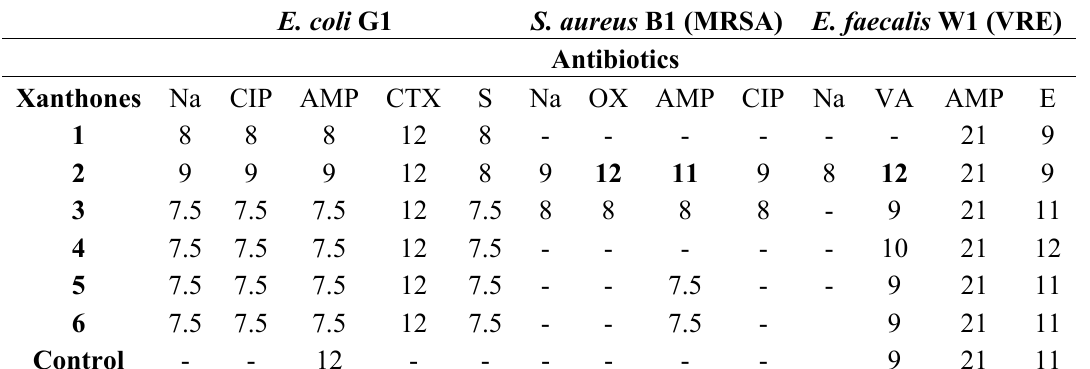
Table 2. Combined effect of antibiotics and polyhydroxylated xanthones (15 µg/disc) against three multidrug-resistant isolates, using the disc diffusion method (inhibition halos are expressed in